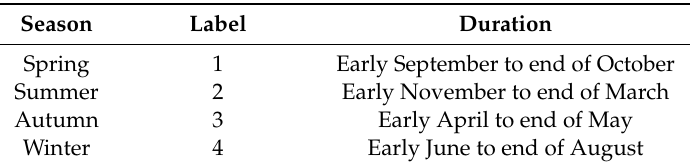
Table 1. Division time of four